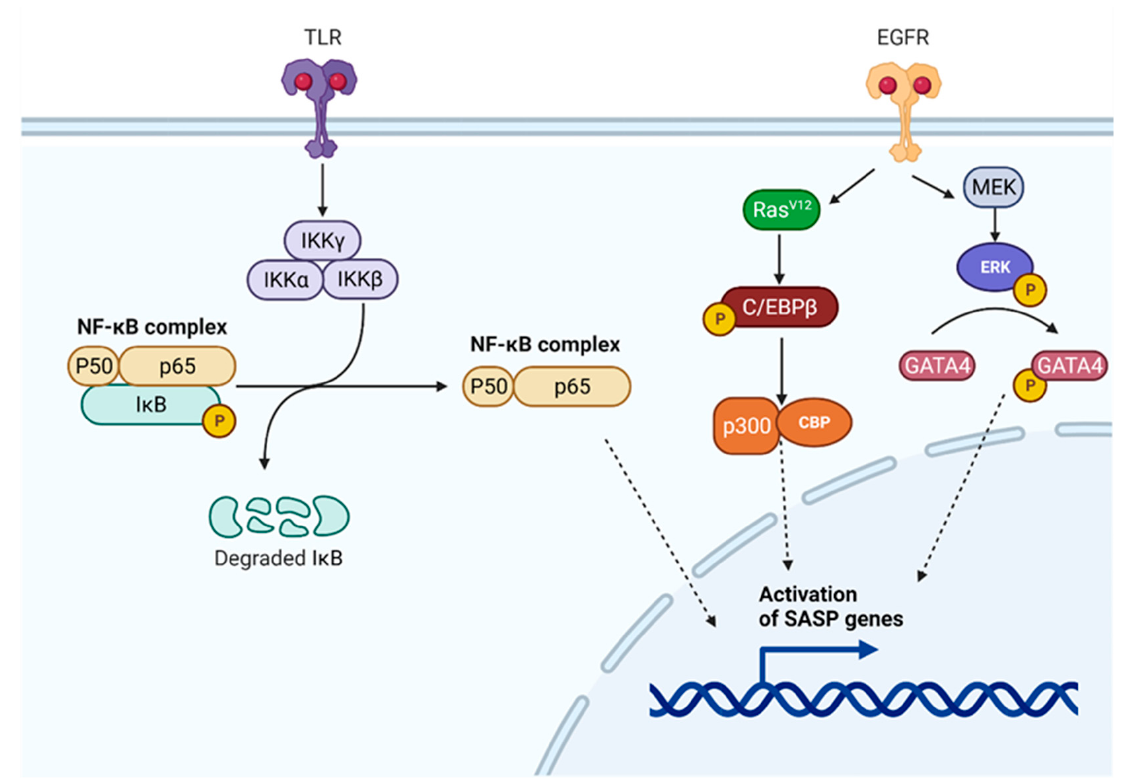
Figure 3. Main SASP regulatory pathways. SASP genes activation through the NF- κ B transcription factor as the main regulator, in addition to C/EBP β , p53, and GATA4.